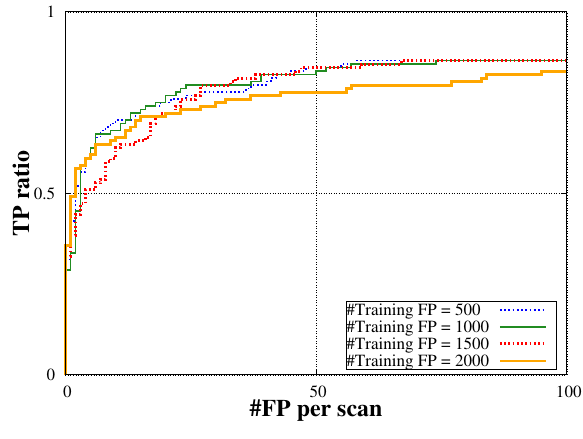
Figure 12. FROC curves of individual FP numbers for training in FP reduction.